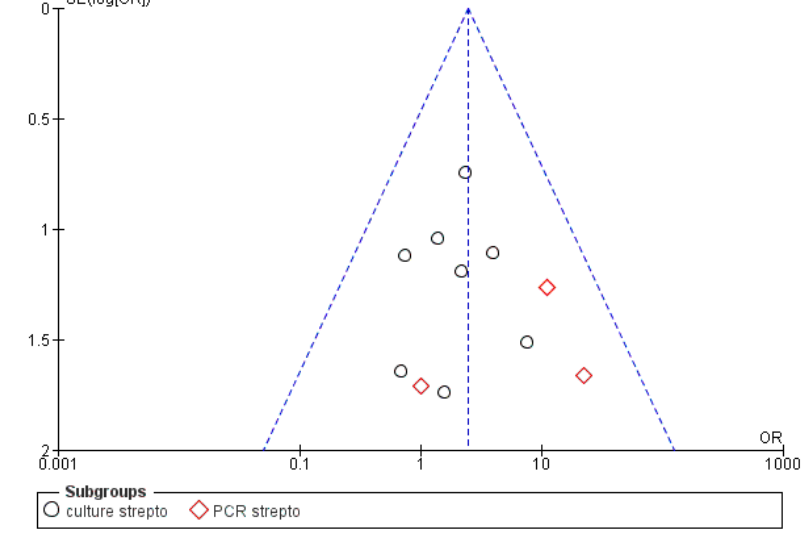
Figure 2. Funnel plot for the sub-group Streptococcus, I 2 = 0%. The absence of heterogeneity is evident graphically. Sub-group culture I 2 = 0%. Sub-group PCR I 2 = 0%. The heterogeneity between the two sub-groups is I 2 = 58.2%. OR: odds ratio, SE: standard error.